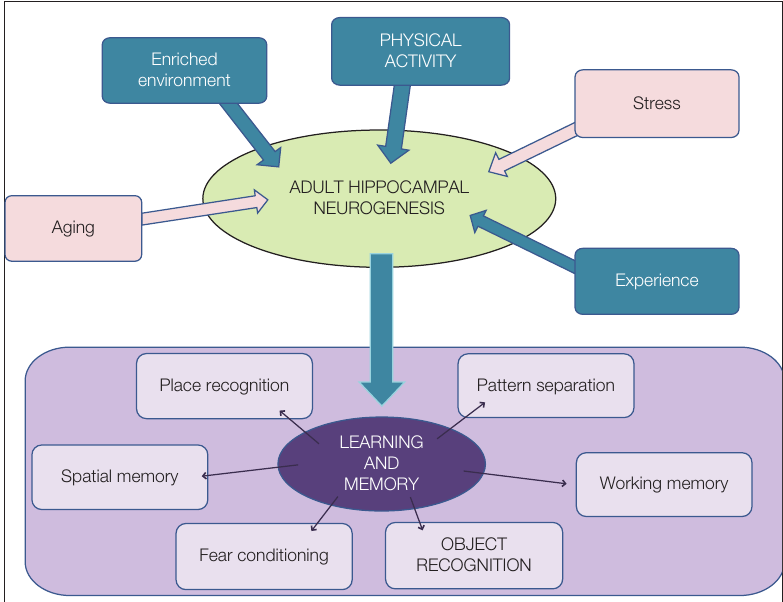
FigURe 1 | Regulation of adult neurogenesis can modulate learning and memory. Whereas aging and stress downregulate adult neurogenesis (pink arrows), experience, enriched environment and physical activity (blue arrows) stimulate the generation of new neurons. This could thus lead to better performance in learning and memory tasks.